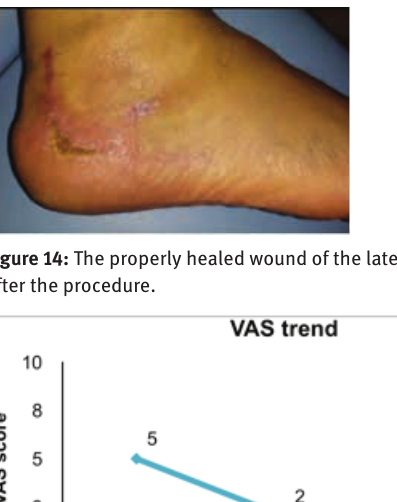
Figure 12: Immediate post-operative antero-posterior and lateral plain radiograph demonstrating filling the void with CERAMENT together with the allogenic bone debris after the resection of the lesionin the course of the Gaucher disease.